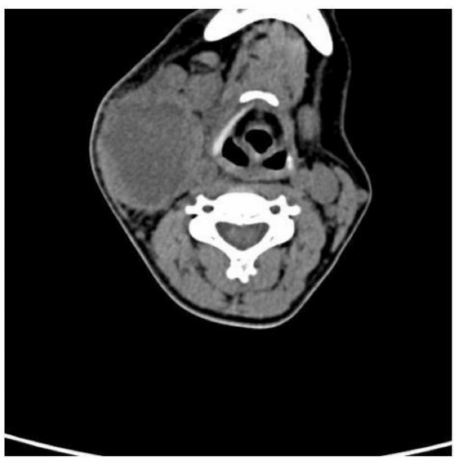
Figure 1. Contrast CT of the neoplasm. Description is given in the main